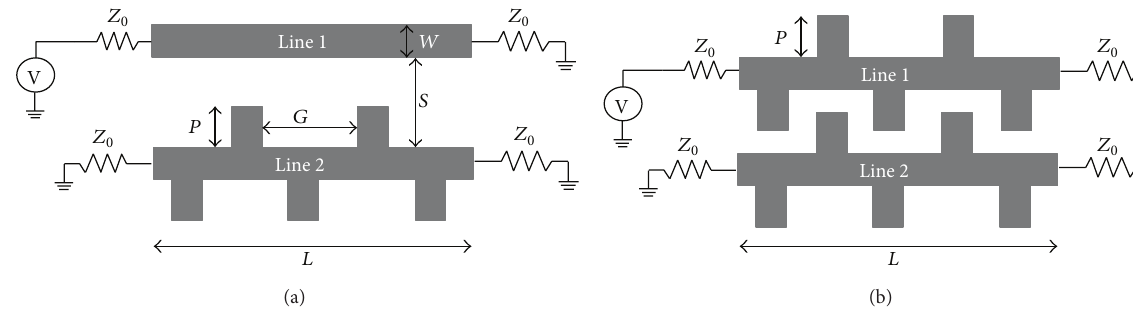
Figure 3: (a) Single stub configuration. (b) Double stub configuration.